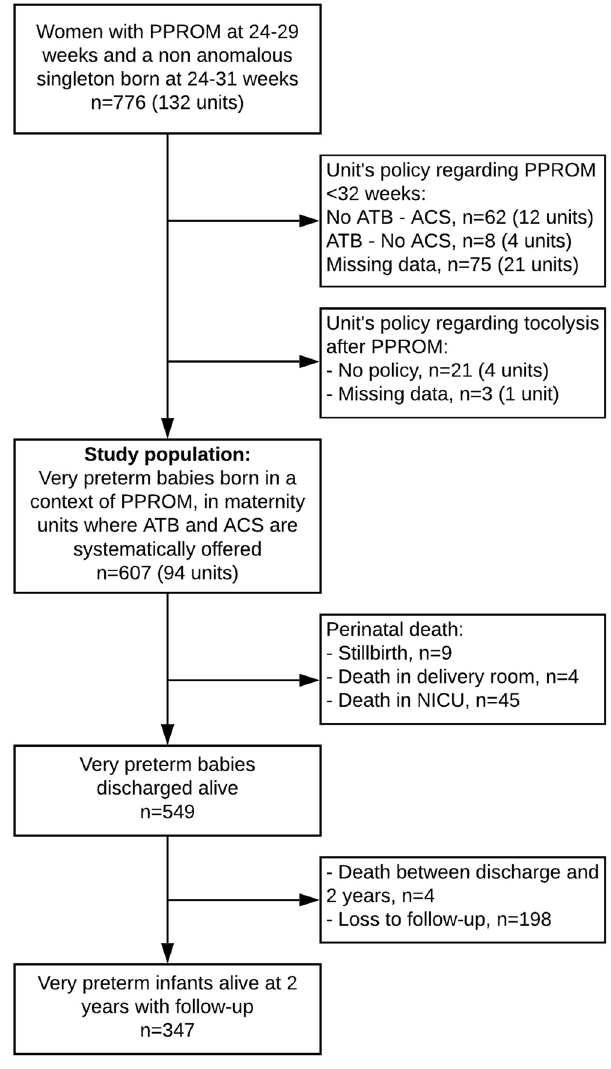
Figure 1. Flow Chart. ATB: antibiotics, ACS: antenatal corticosteroids, NICU: neonatal intensive care unit, PPROM: preterm premature rupture of membranes. Some units had different policies for ACS administration according to gestational age at PPROM, the policy of ACS was then defined at an individual level according to both unit policy and GA at PPROM, explaining slight differences in the total number of units excluded and the number of units after